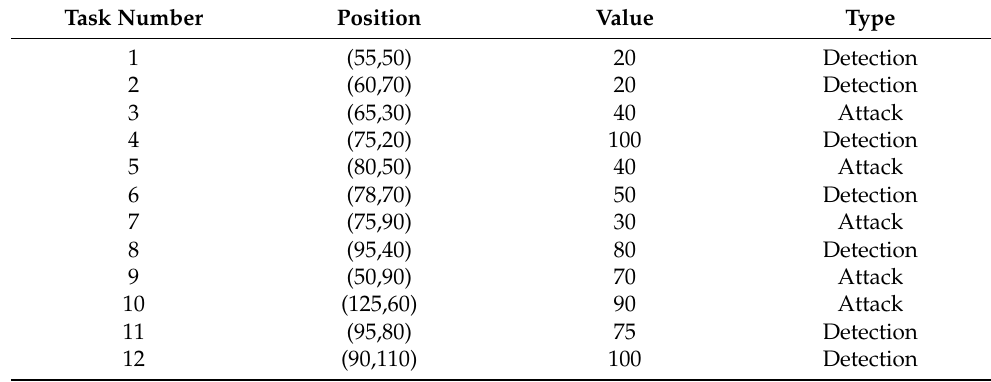
Table 1. Air-to-ground task parameters.